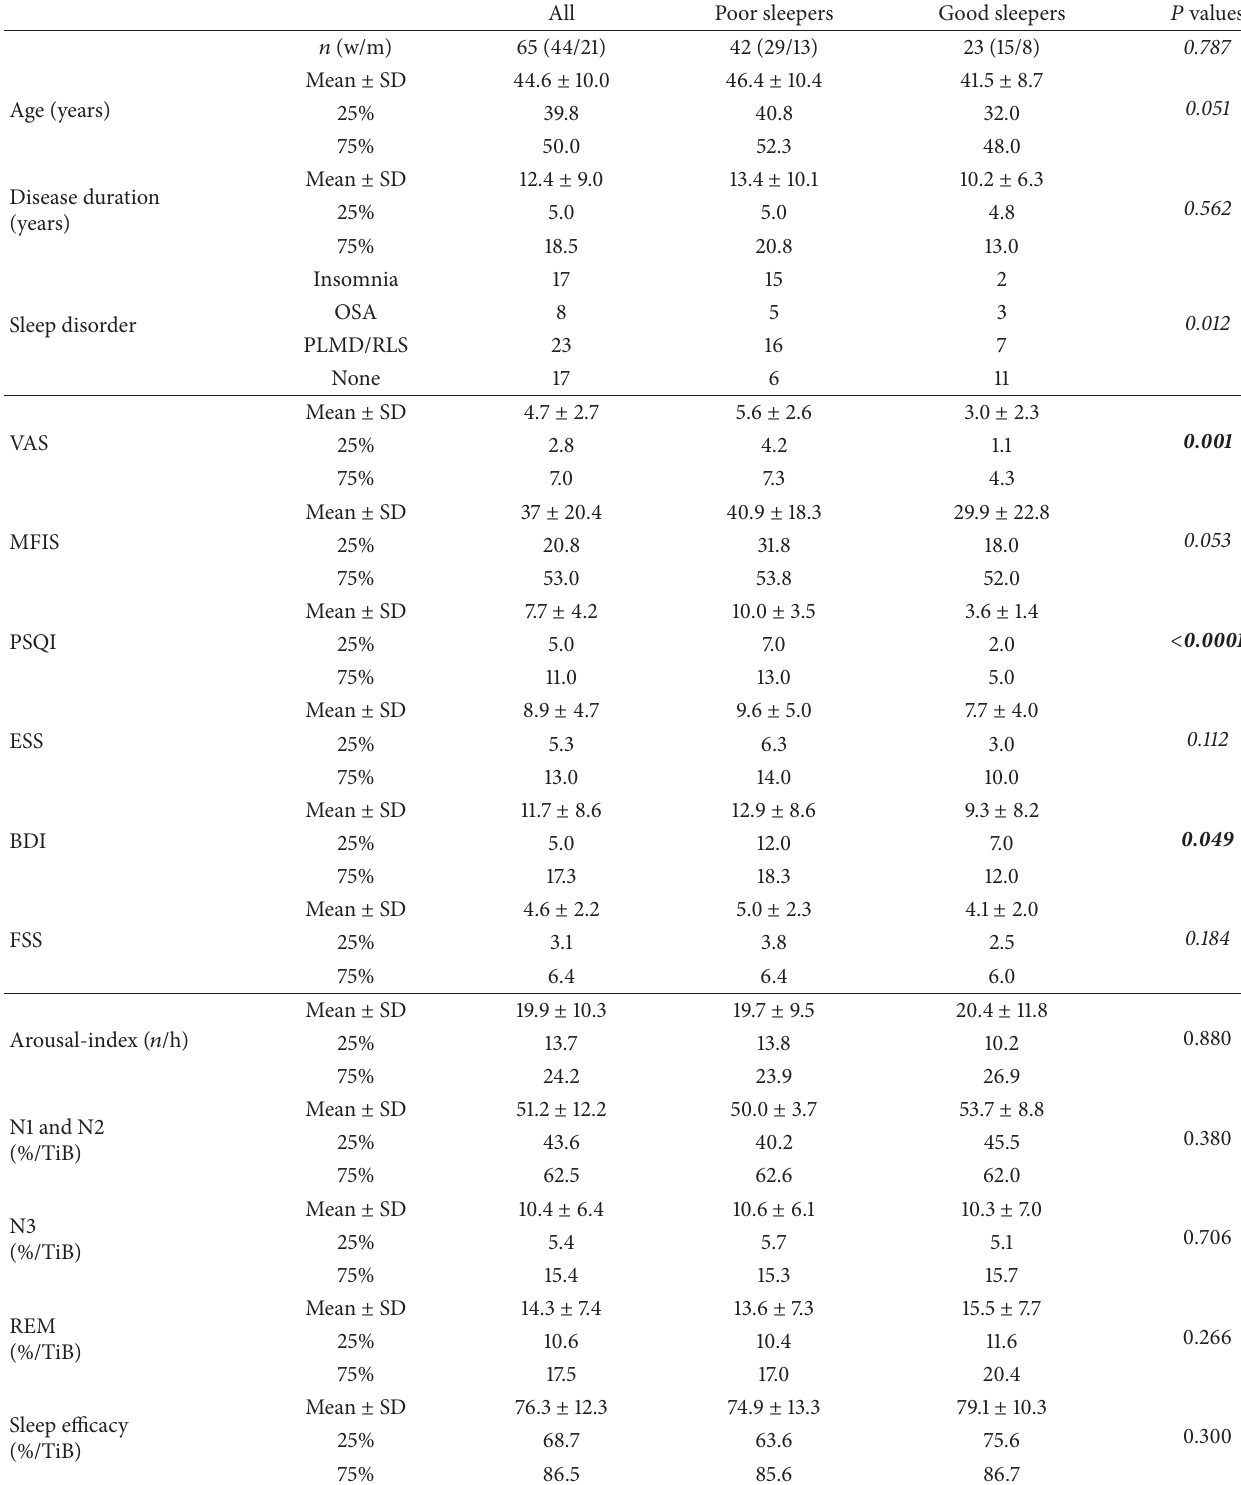
Table 1: Demographic data and results of questionnaires and